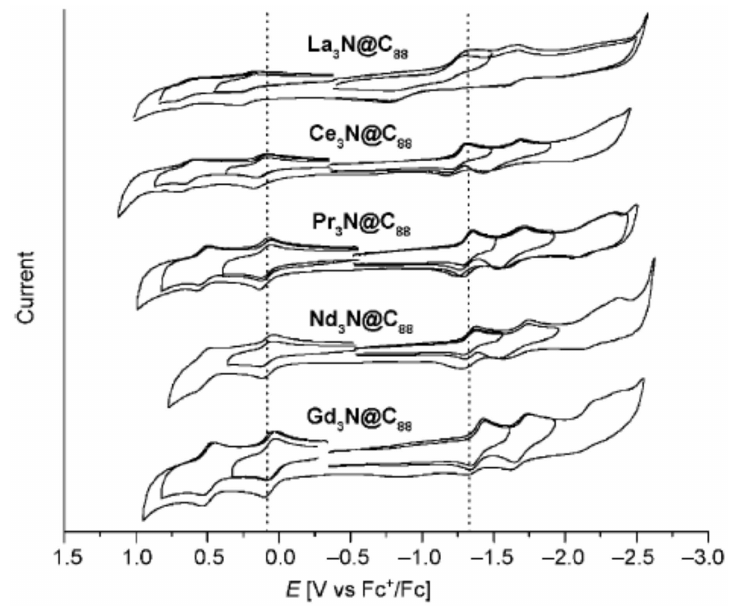
Figure 6. Cyclic voltammograms of M 3 N@C 88 (M = La, Ce, Pr, Nd, and Gd), with ferrocene as the internal